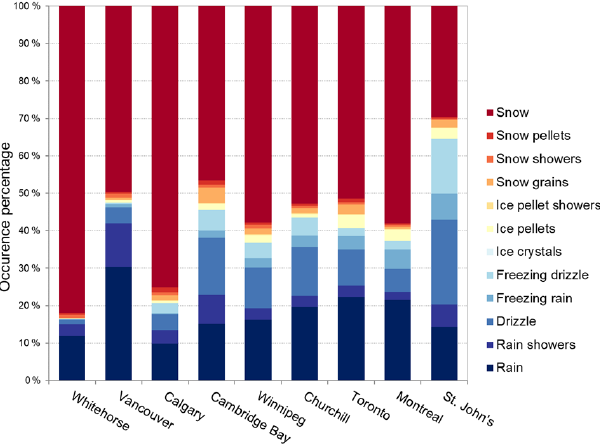
Figure 7. The distribution of the occurrence of the different precip- itation types under near-0 ◦ C conditions at each of the nine stations over the 1981–2011 period. Stations are arranged from west to